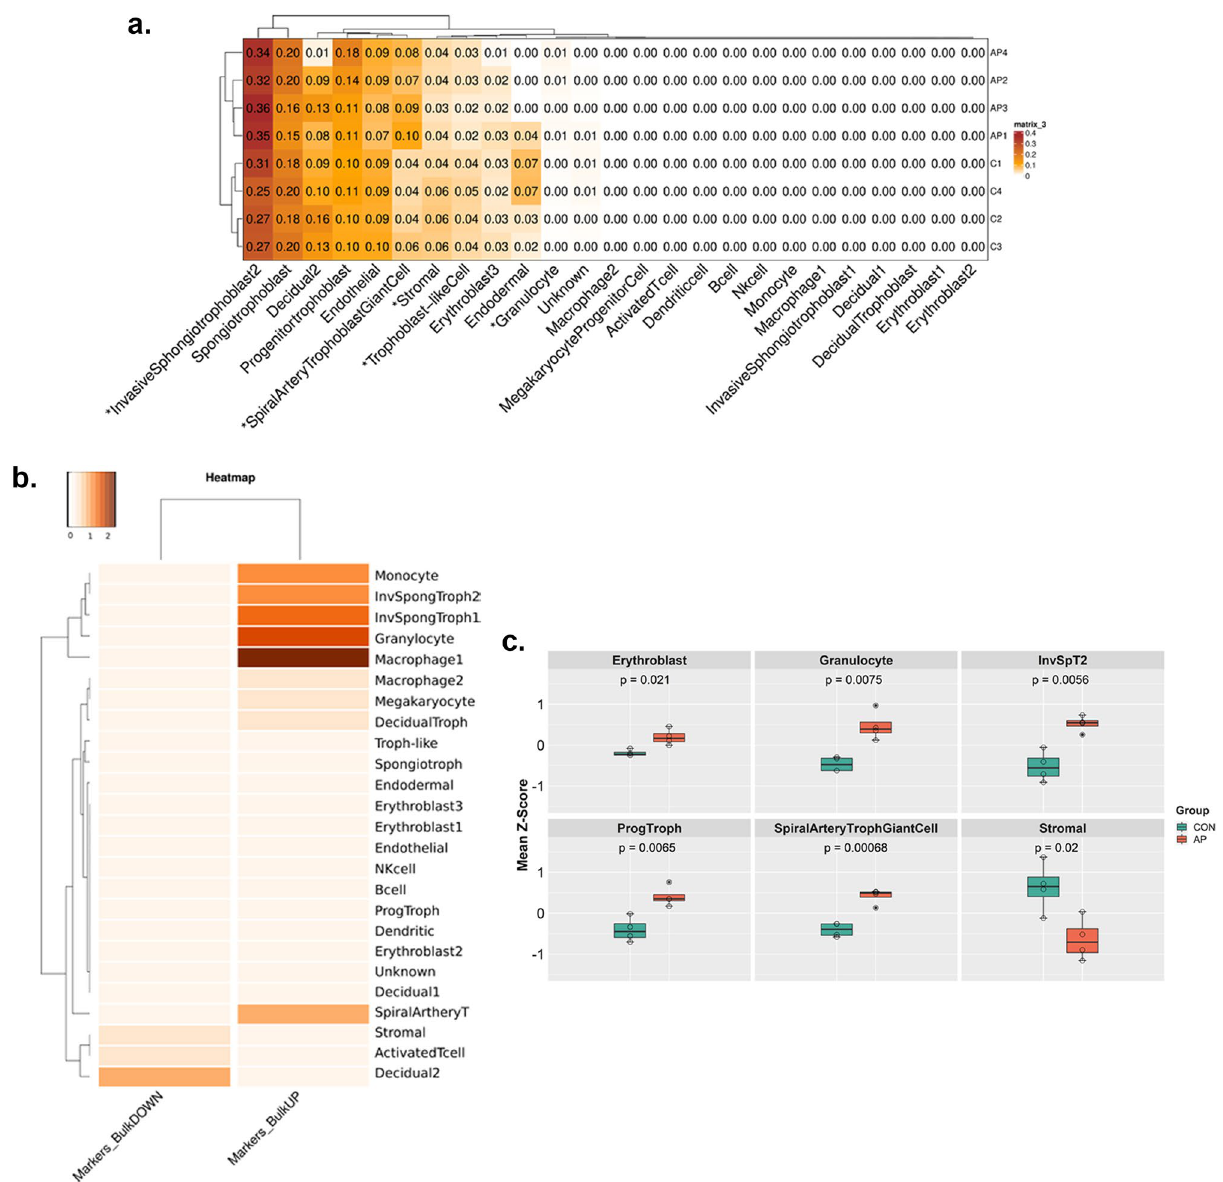
Figure 2. Deconvolution of Bulk RNA-Seq data. ( a ) Cell-type deconvolution of bulk RNAseq data based on pseudobulk scRNAseq as a reference. Numbers present a fraction of the total count. Stars represent an FDR- corrected significant difference (t-test) between the detected cell type fractions in AP (air pollution; n = 4 sequenced samples obtained from 6 pregnant mice) and CON (control; n = 4 sequenced samples obtained from 6 pregnant mice) at a level below 0.05. ( b ) Overlap between the 50 top marker genes for each tissue (Supplementary Table 2) type in the scRNAseq dataset and genes up- or downregulated in AP versus CON detected by bulk RNAseq (Supplementary Table 3). A higher value (depicted with darker color) represents a higher level of overlap. ( c ) Differential abundance of cell types based on z-scores calculated using cell specific marker genes from scRNAseq analysis which were significantly expressed among all samples and filtered by p value < 0.05. Students t-test was performed to calculate the significance between two groups InvSpT1 = Invasive Spongiotrophoblasts Type 1. InvSpT2 = Invasive Spongiotrophoblasts Type